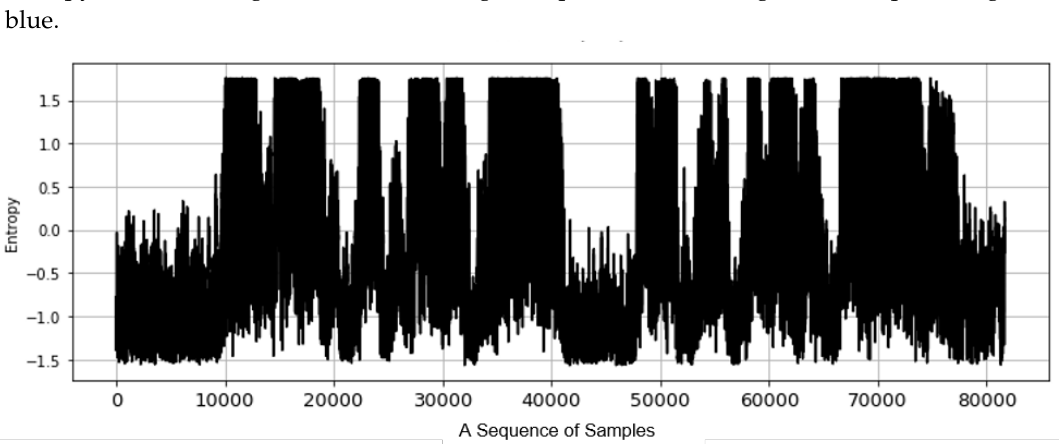
Figure 10. Entropy of a sample audio signal.